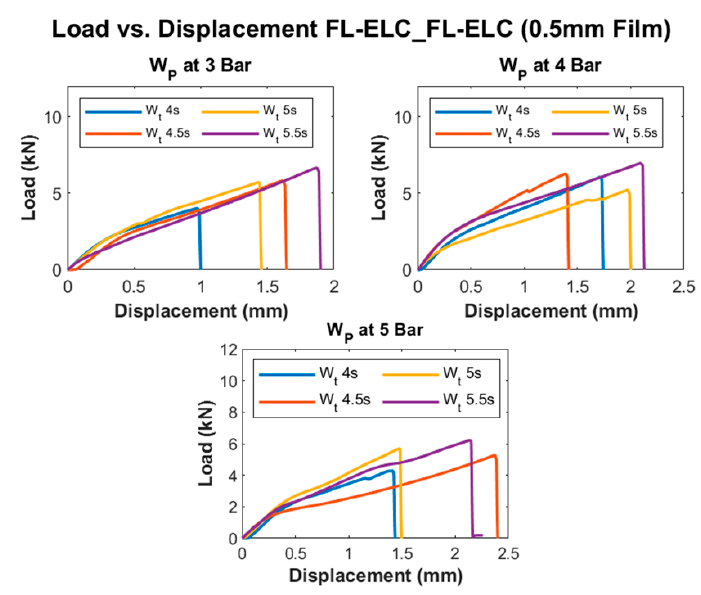
Figure 17. Load vs. Displacement curve of FL-ELC_FL-ELC (0.5 mm film ED).